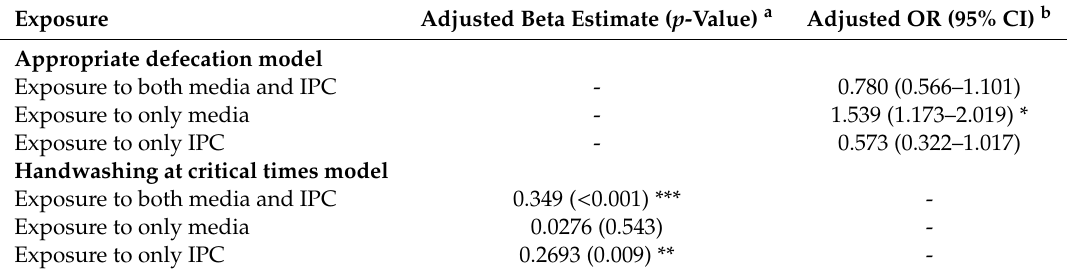
Table 5. Regression analysis with behavior for defecation and